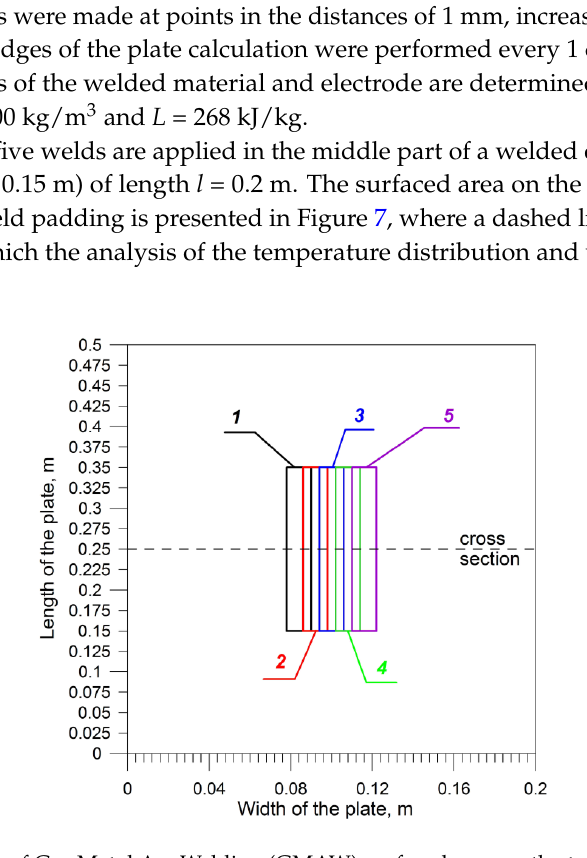
Figure 7. The scheme of Gas Metal Arc Welding (GMAW) surfaced area on the top surface of the plate with the sequence of the weld padding.